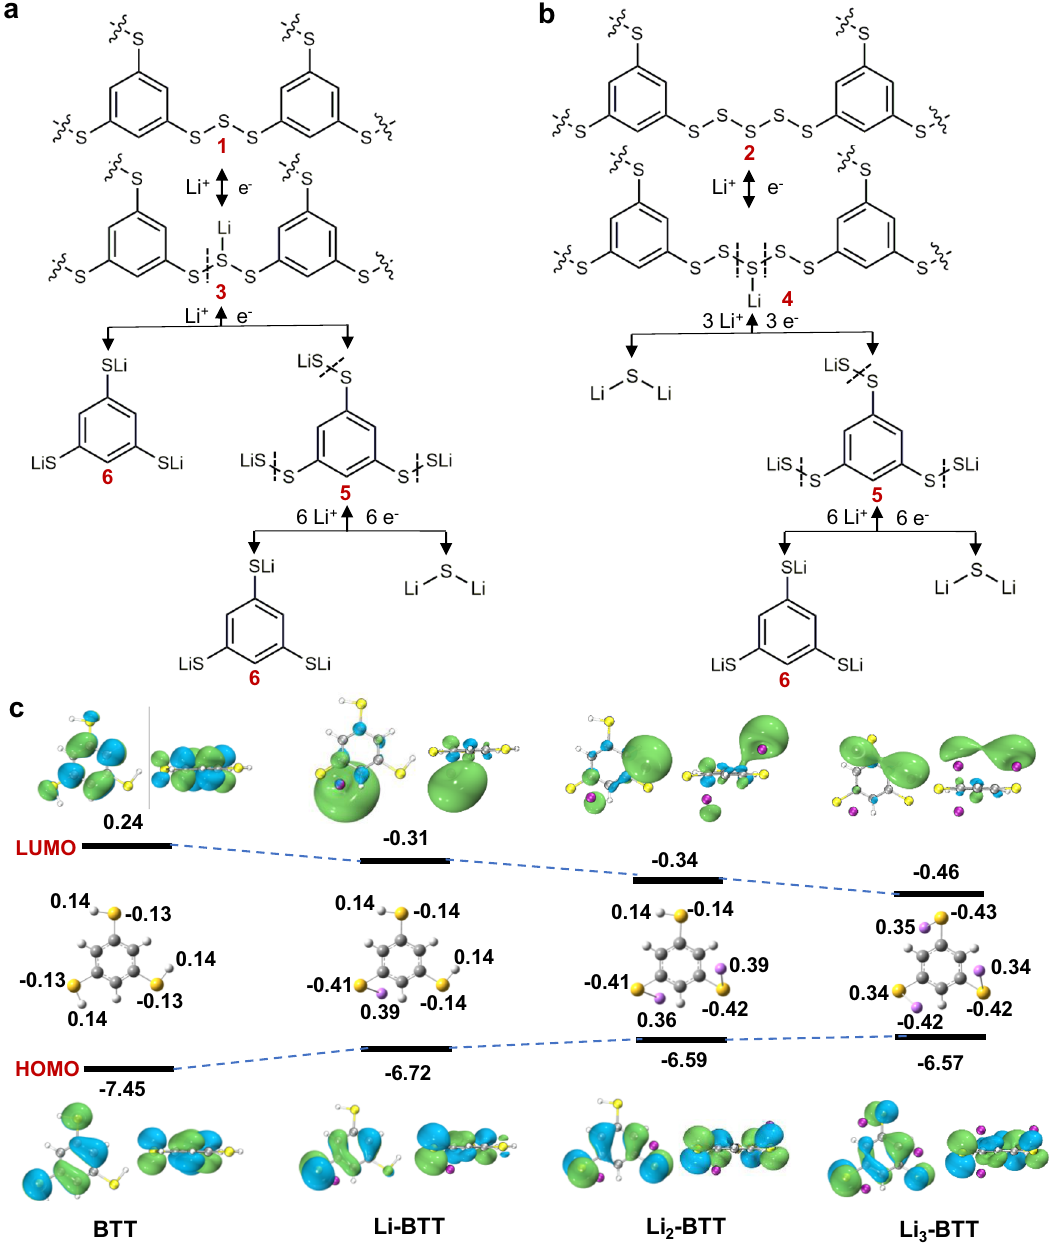
Fig. 5 Scheme of redox process and molecular orbital energies. a , b Redox reaction process of the Li-S rechargeable battery with BTT electrolyte. c The frontier molecular orbitals (MO) energies density and the Mulliken atomic charge distribution of state of the BTT and the lithiation products of